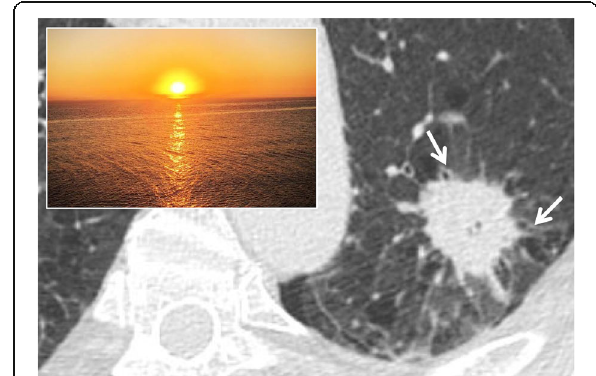
Fig. 32 Sunburst sign. A CT image of a 61-year-old female affected by lung adenocarcinoma. The parenchymal neoplastic lesion shows spiculated and irregular margins, resembling the appearance of a “ sunburst ” : the rays or the speculated margins are constituted by the distorted blood vessels and/or by thickened septa that surround the pulmonary mass